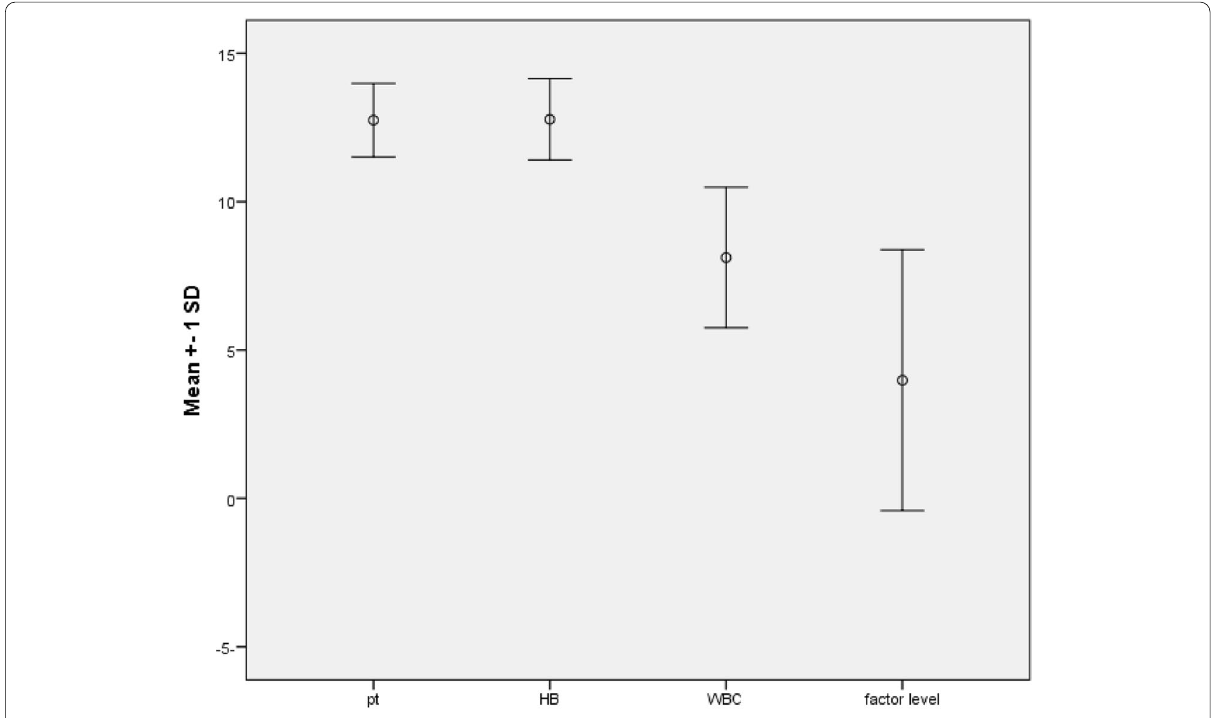
Fig. 3 Clinical investigations (PT, HB, WBC, and factor level) in the studied patients